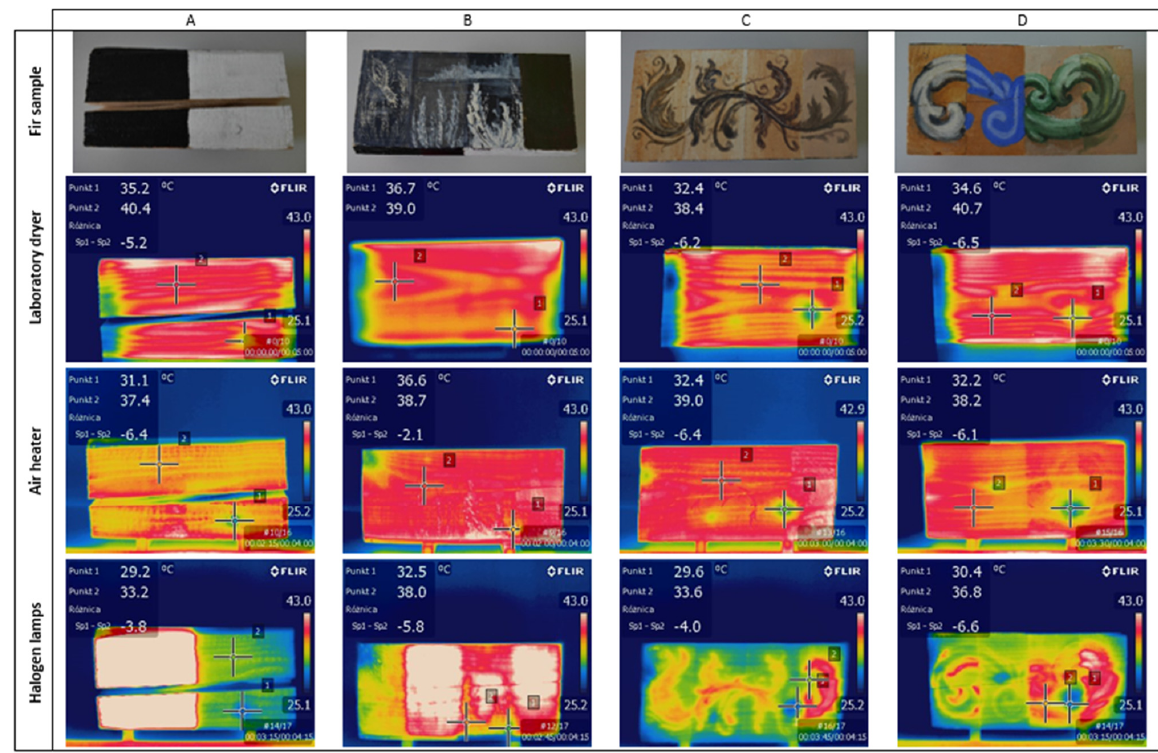
Figure 6. The comparison of the painted surface areas of fir wood with the results of IR thermography: A ÷ D surfaces of tested element.